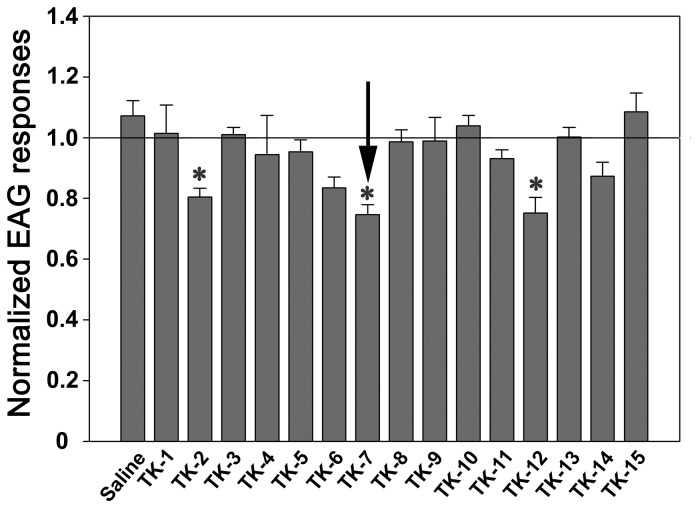
Normalized EAG responses of cockroach antennae to ethyl acetate (10-2 dilution) after injection of tachykinin (TK) peptides.EAG amplitudes were decreased after injection of TK-2, -7, and -12, compared to other TK peptides and control saline injection (N=4-8, ANOVA with Bonferroni correction, *=p<0.05). TK-7 (arrow) showed strongest effects on decrease of olfactory responses, which was in turn used for further experiments. Effects of other TKs on EAG responses were not significantly different from saline control injection. Information on synthesized TK peptides was as follows: PaTK1: APSGFLGVR-NH2, PaTK2: APEESPKRAPSGFLGVR-NH2, PaTK3: NGERAPASKKAPSGFLGTR-NH2, PaTK4: APSGFLGTR-NH2, PaTK5: APGSGFMGMR-NH2, PaTK6: APAMGFQGVR-NH2, PaTK7: APASGFFGMR-NH2, PaTK8: VPASGFFGMR-NH2, PaTK9: GPSMGFHGMR-NH2, PaTK10: APSLGFQGMR-NH2, PaTK11: APNMGFMGMR-NH2, PaTK12: MGFMGMR-NH2, PaTK13: GPSVGFFAMR-NH2, PaTK14: APSAGFMGMR-NH2, PaTK15: APSAGFHGMR-NH2.